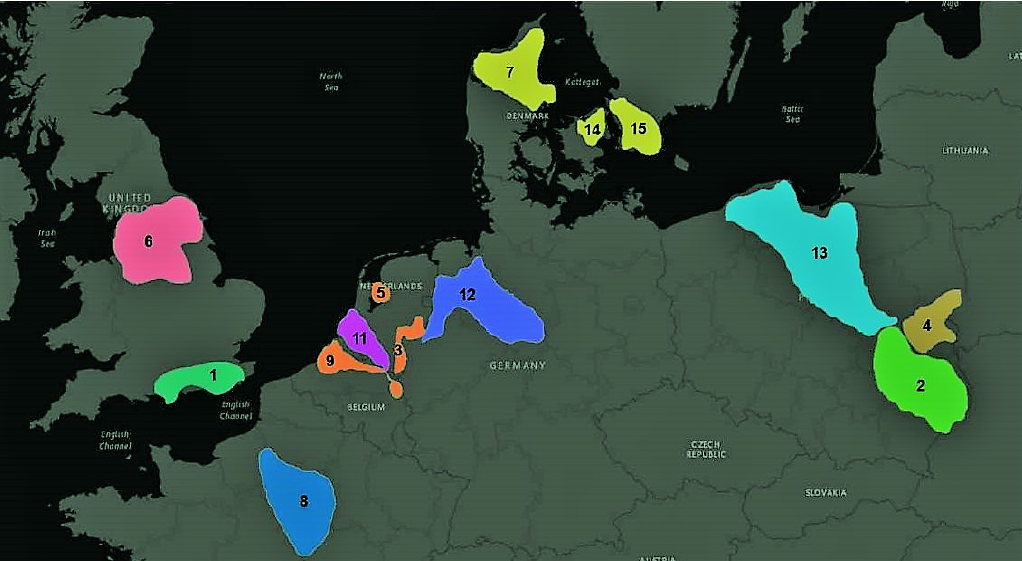
Figure 1. The location of the selected shale gas plays (see also Table 1). Note that play number 1 (Weald Basin) shown here is not further used as it contains mostly shale oil and only little shale